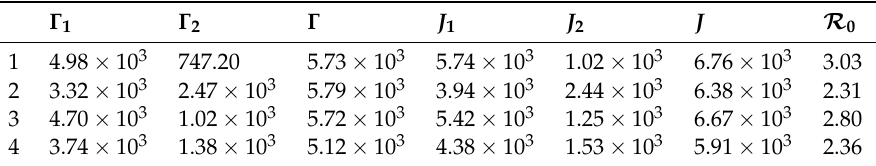
Table 4. The total number of newly infected animals over a ten-year period and the total cost J with respect to the control strategy under Scenario